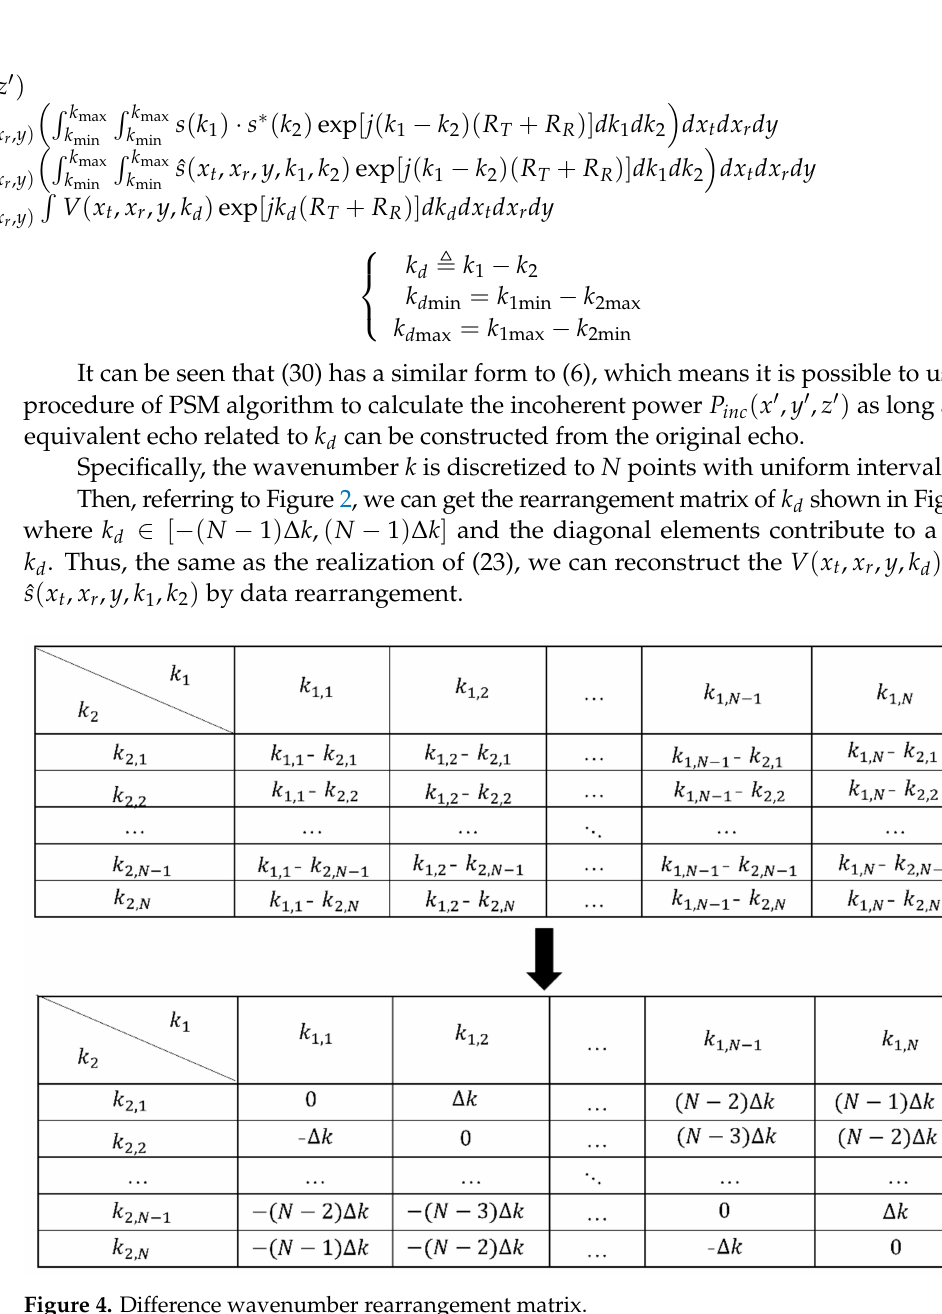
Figure 4. Difference wavenumber rearrangement